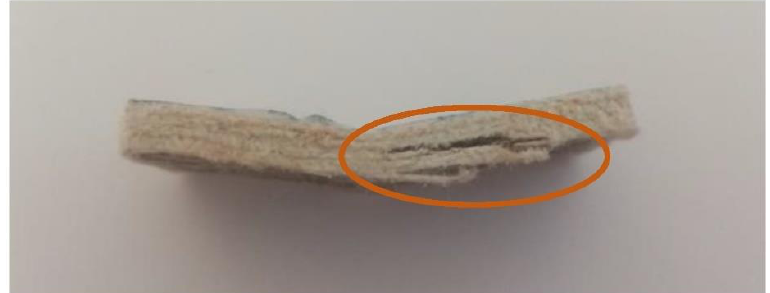
Figure 14. Short beam strength of produced composites.